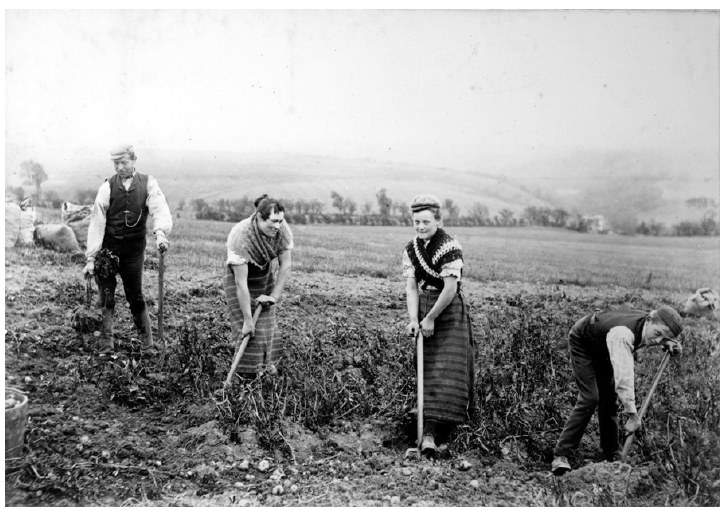
Figure 1. Tattie howkers digging potatoes. John Clark Maddison Collection, circa the late 1890s. Used with permission.